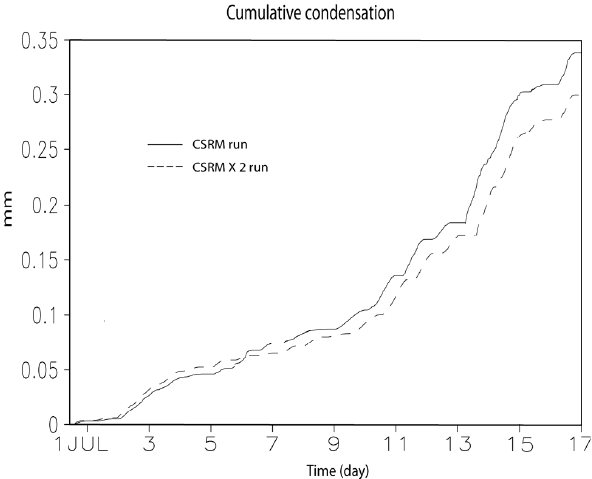
Fig. 18. Time series of cumulative condensation (mm) averaged over the horizontal domain for the CSRM run and the CSRM × 2 run prior to 00:00LST 17 July. Fig. 17c. Figure 17e, depicting the area-averaged profile